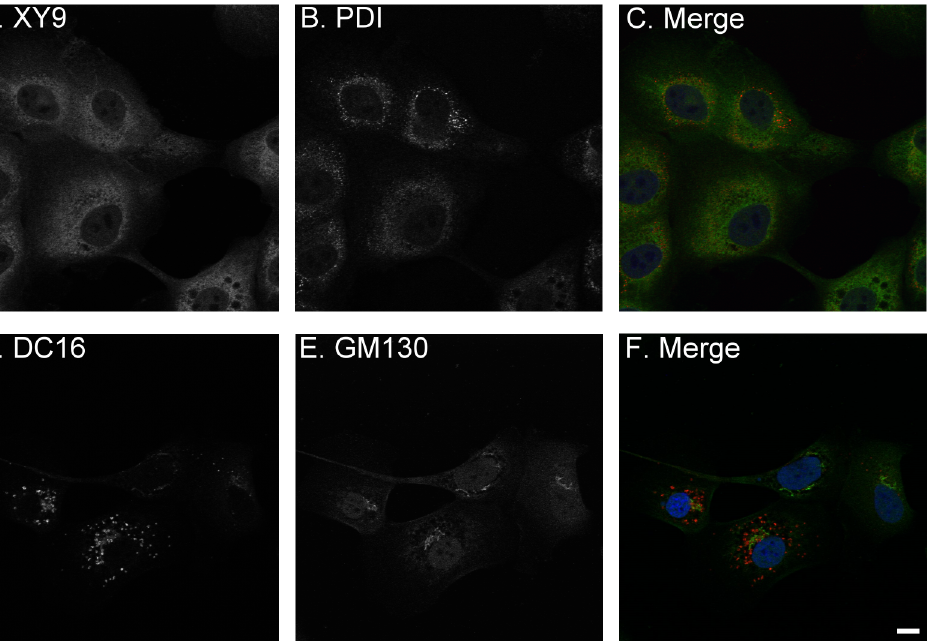
Fig 3. Subcellular localization of HAI-2 species in human mammary epithelial cells. The subcellular localizations of 25-kDa HAI-2 (A and C, green), compared with protein disulfide isomerase (PDI), an ER marker (B, and C, red) and 30-40-kDa HAI-2 (D and F, red), compared with GM130, a cis-Golgi marker (E and F, green) were analyzed by immunofluorescent double staining. The cells were also stained for nuclei using DAPI (blue), as a counterstain. The staining is presented as black and white images (A, B, D, and E) or merged false-color images (C and F). Scale bar: 10 μ